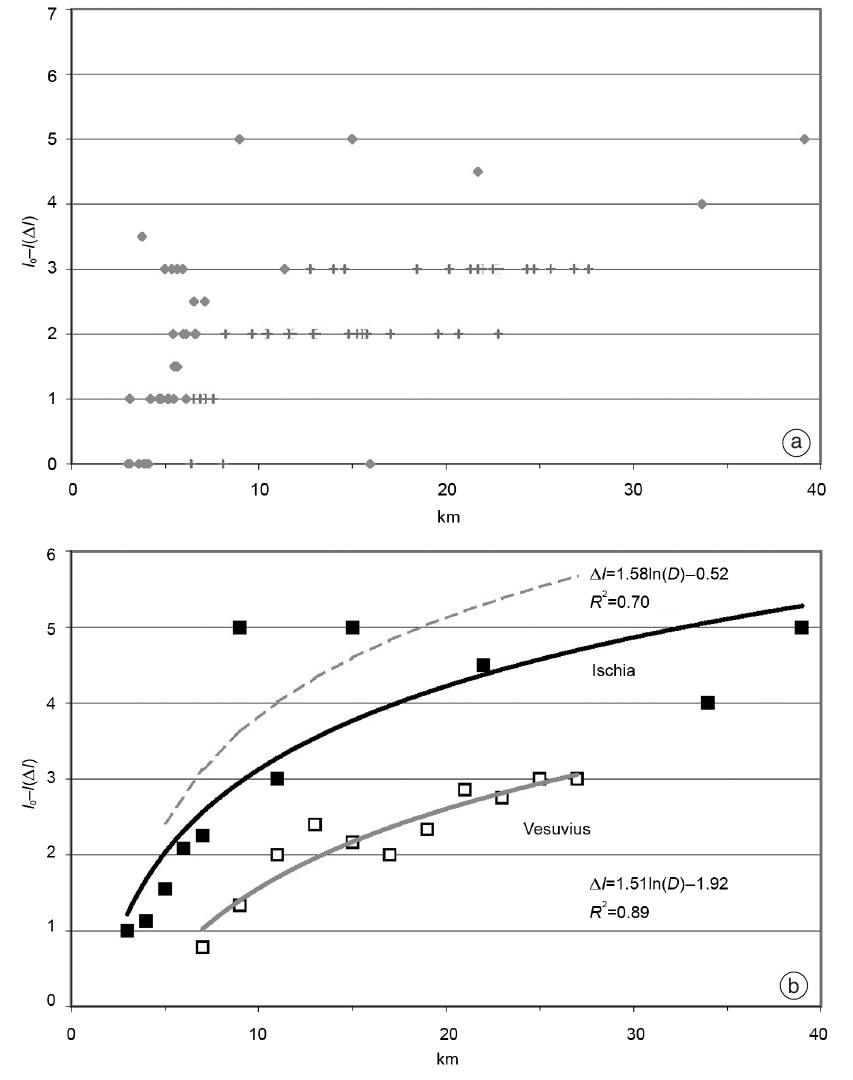
Fig. 11a,b. Neapolitan volcanic district. a) Hypocentral distances versus ∆ I for the earthquakes used in the analysis: Ischia, diamonds; Vesuvius, crosses. b) Logarithmic relationships for the arithmetic average of ∆ I (squares) for Ischia and Vesuvius and comparison with the Peruzza (2000) equation